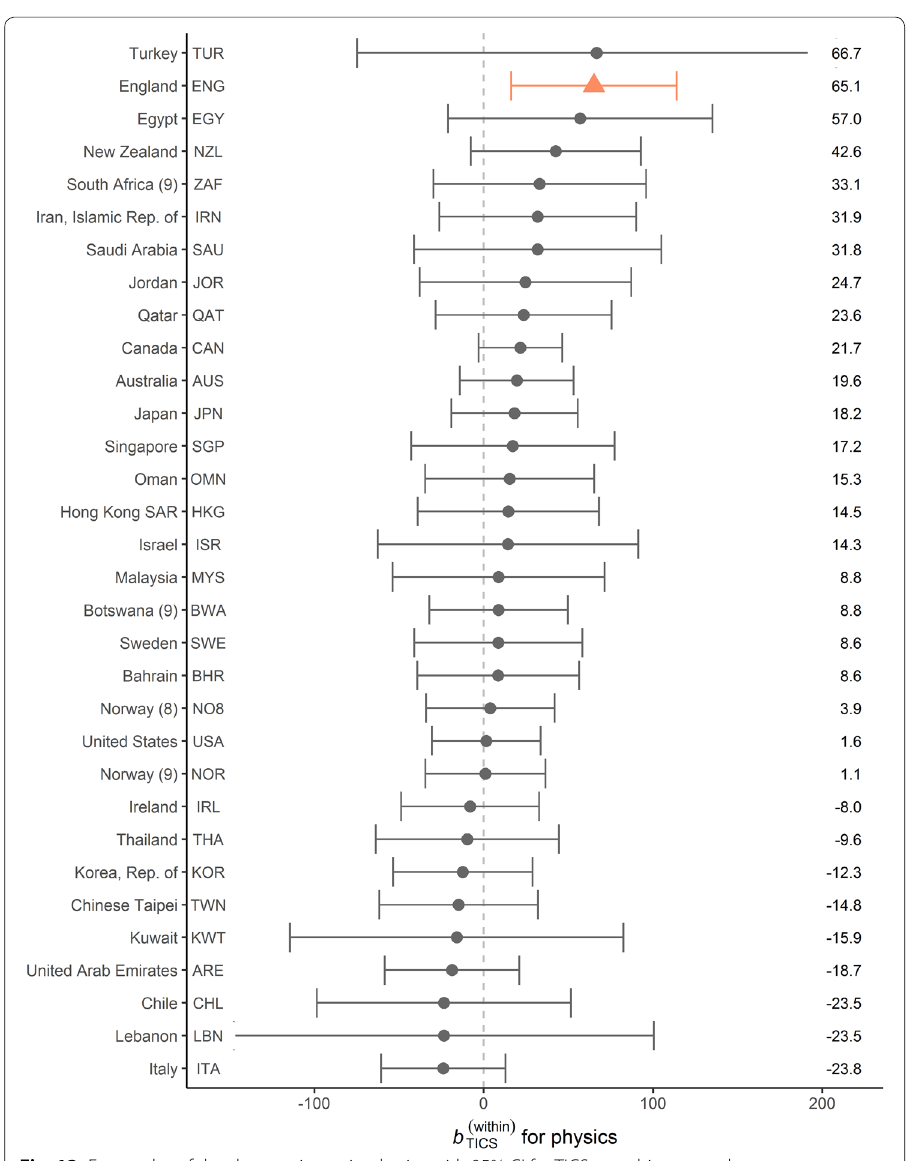
Fig. 13 Forest plot of the slope estimate in physics with 95% CI for TICS on achievement by